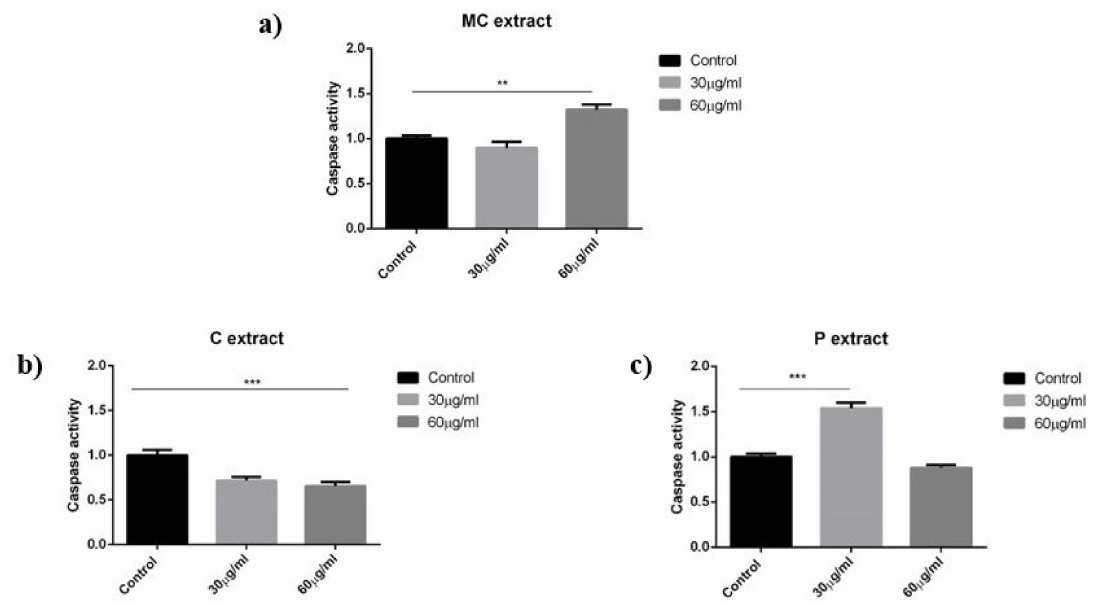
Figure 5. Caspase 3 activity of A375 human melanoma cells after 72 h of incubation with ( a ) MC extract; ( b ) C extract; ( c ) P extract. Statistical significance was assessed by one-way ANOVA with Newman–Keuls post-test for comparison of multiple groups ** and *** indicate p < 0.01 and p < 0.001, respectively, compared to the control